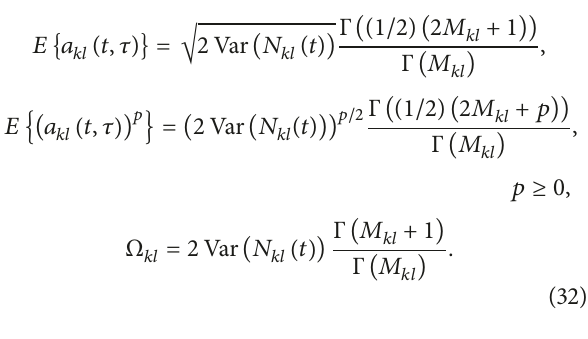
Figure 5: Measured and estimated received signals using the EM algorithm combined with the EKF for the 1st, 2nd, and 3rd clusters. where 𝐿 is the total number of clusters, 𝐾 𝑙 is the total num- ber of resolvable delay bins (paths), and 𝑀 𝑘𝑙 is the number of cluster 𝑙 . In this case, the tap weight process 𝑎 𝑘𝑙 (𝑡, 𝜏) has the following statistics